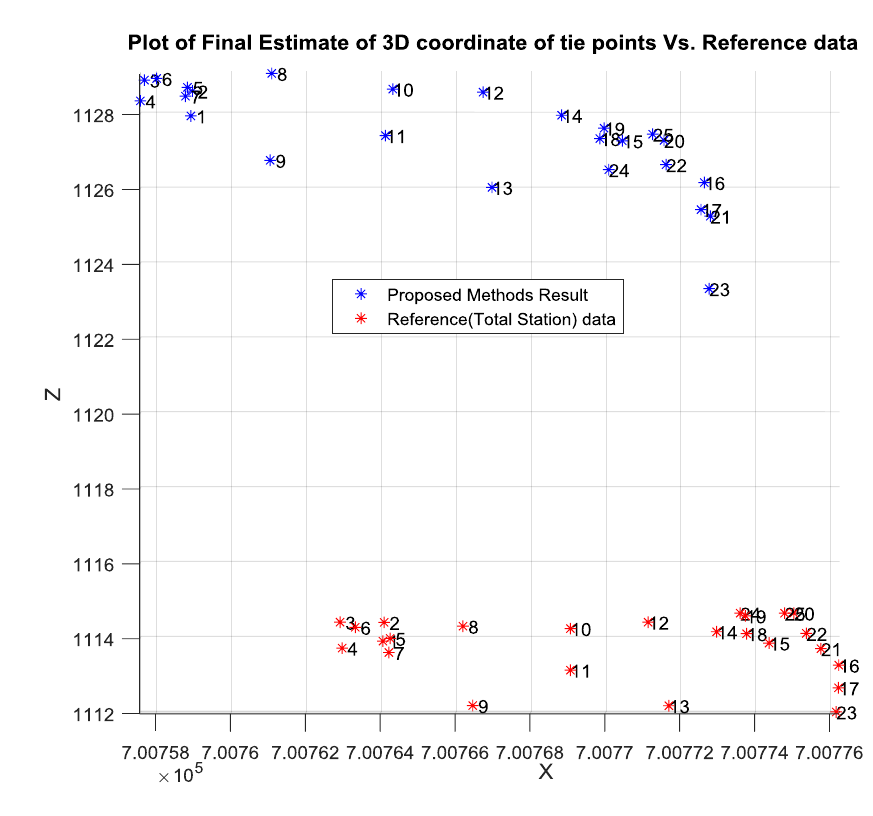
Figure 16. Estimated vertical coordinates of tie point.